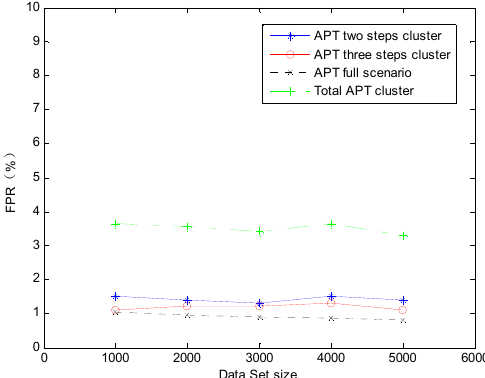
Figure 11. The false-positive rate (FPR) varies with the data set size changes.